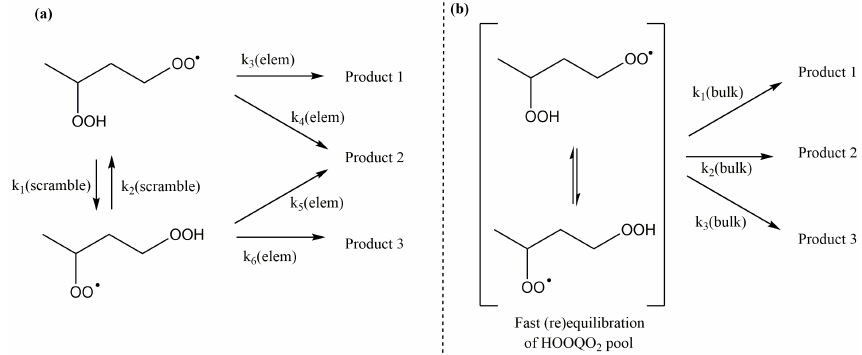
Figure 8. Illustration of fast scrambling and the use of bulk rate coefficients to reduce the complexity of the kinetic model, with (a) the explicit model and (b) the model using a single lumped pool (in square brackets). In the example above, k 2 (bulk) is the sum of the bulk rate coefficients for each of the two channels. The scheme is trivially extended to more isomers and reaction